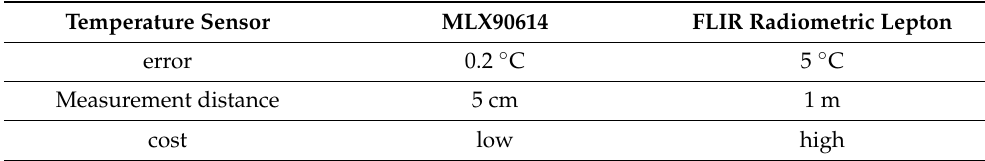
Table 3. Comparison of different temperature sensor.